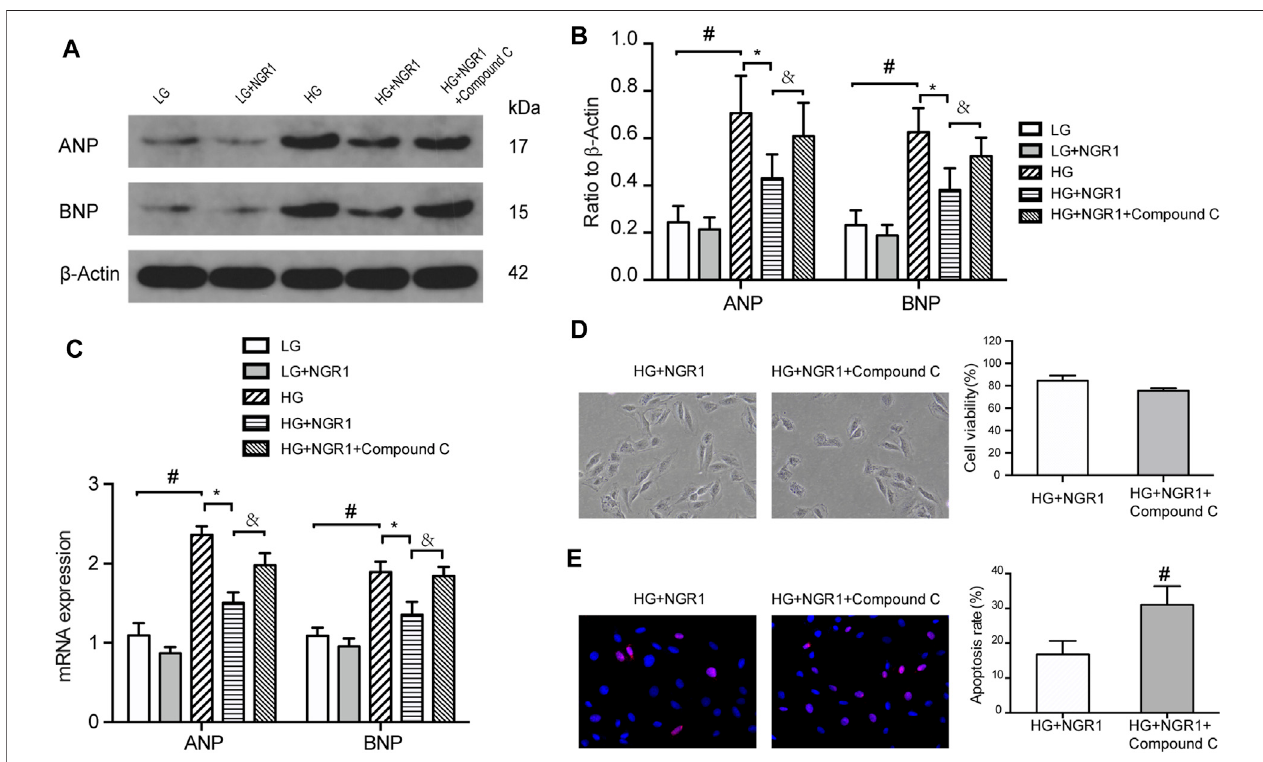
FIGURE 3 | The AMPK pathway mediates the protective effects of NGR1. (A) Expression of ANP and BNP proteins in H9c2 cells by Western blot analysis. (B) Densitometric analysis of ANP and BNP expression in cardiomyocytes. (C) ANP and BNP mRNA expression (D) H9c2 cell viability and morphological changes induced by compound C. Cell viability in the compound C-treated group was reduced, and the cells became longer and swollen. Images are at × 200 magni fi cation (E) TUNEL staining and apoptosis rate. The apoptosis rate in the compound C-treated group signi fi cantly increased. Images are at × 400 magni fi cation. Data are shown as mean ± SEM of three independent experiments, * p < 0.001, & p < 0.001, and # p < 0.001. LG, 5.5 mM glucose; HG, 30 mM glucose; NGR1, Notoginsenoside